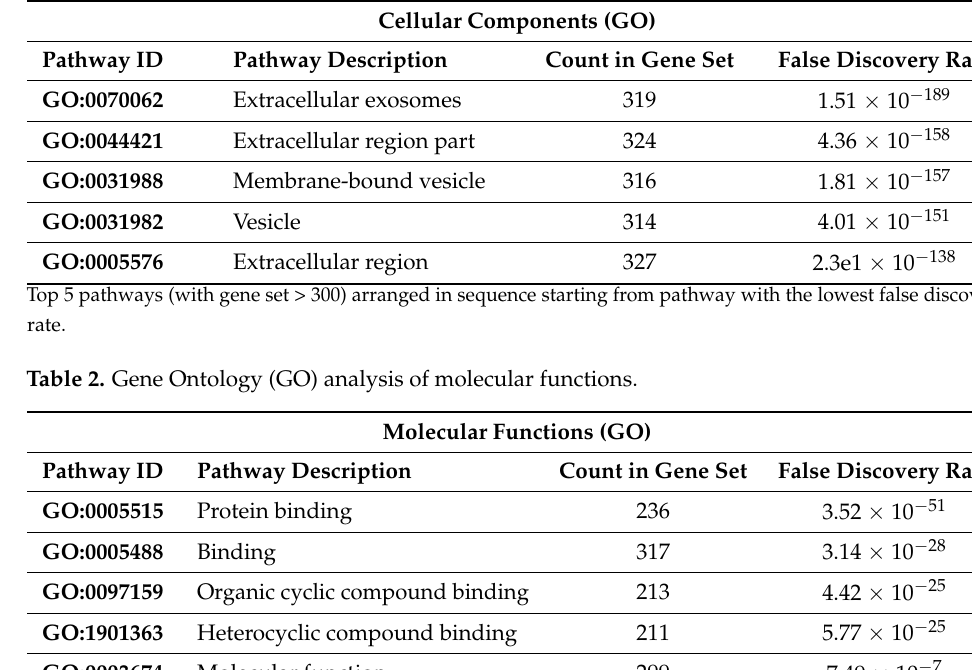
Table 1. Gene Ontology (GO) analysis of cellular components.